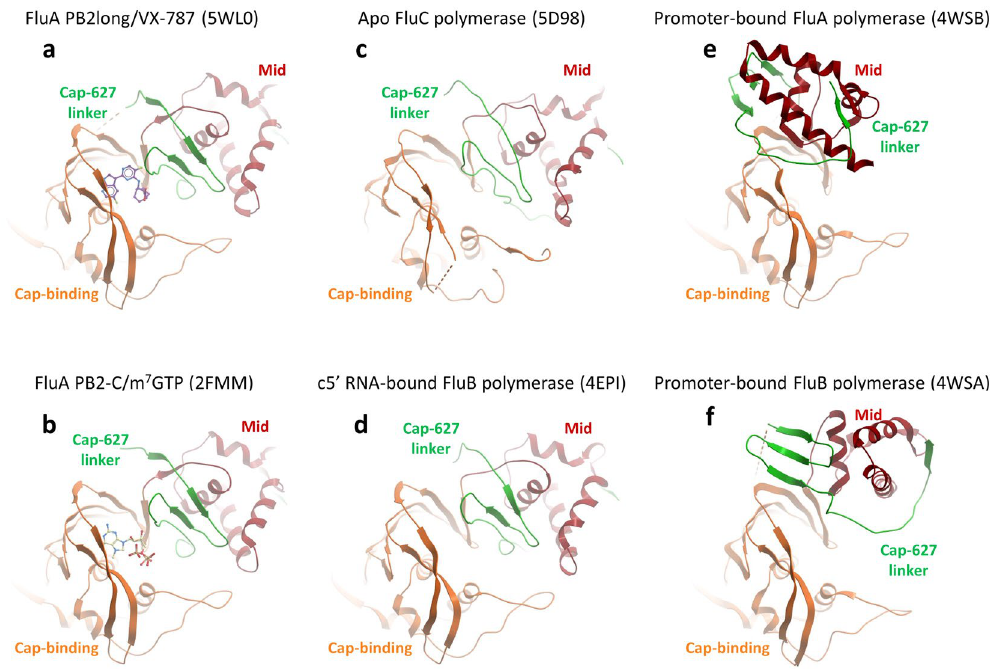
Figure 3. VX-787 targets the transcription pre-activation state of FluA PB2. Comparison of PB2 Mid/Cap- binding/Cap-627 linker in ( a ) VX-787-bound FluA PB2long (this work); ( b ) m7GTP-bound FluA PB2-C (pdb accession 2FMM); ( c ) Apo FluC polymerase (pdb accession 5D98); ( d ) 5 ′ c RNA-bound FluB polymerase (pdb accession 4EPI); ( e ) promoter-bound FluA polymerase (pdb accession 4WSB); ( f ) promoter-bound FluB polymerase (pdb accession